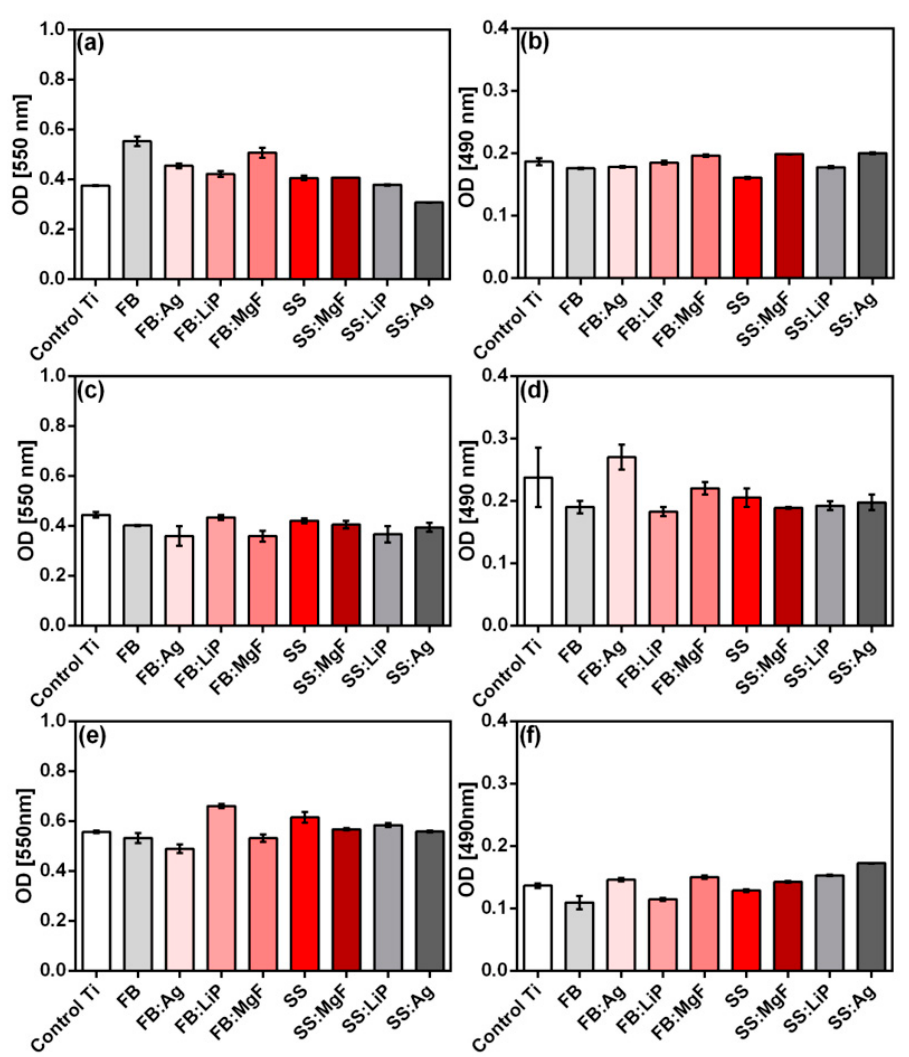
Figure 11. MTT ( a , c , e ) and LDH ( b , d , f ) biocompatibility tests (24 h) in the case of simple and doped FB and SS thin films, using osteoblast ( a , b ), fibroblast ( c , d ), and HeLa ( e , f )